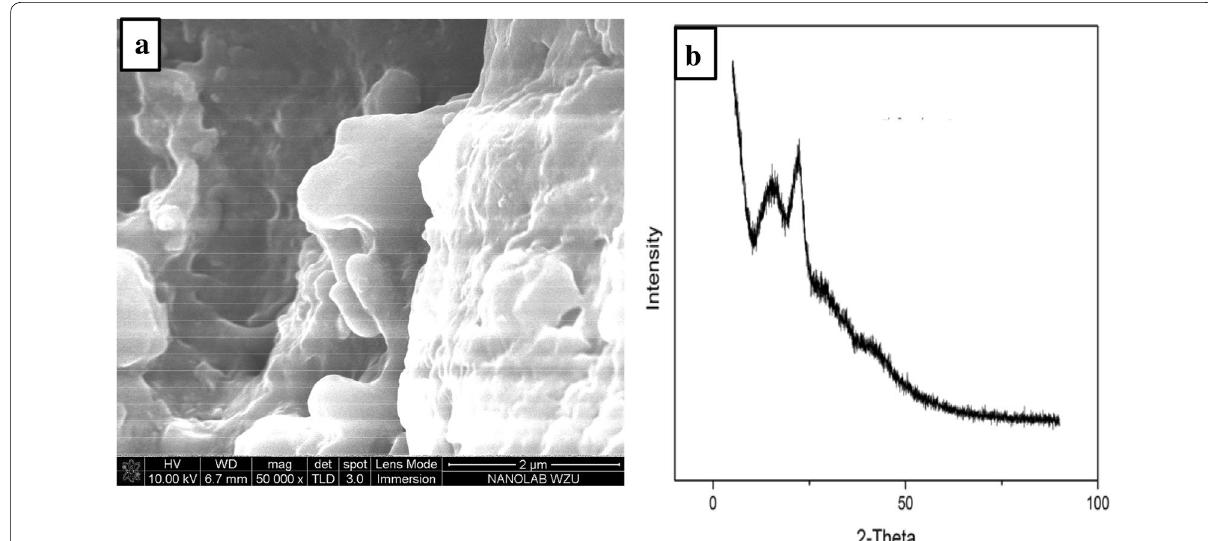
Fig. 2 a SEM image and b XRD of orange peel adsorbent